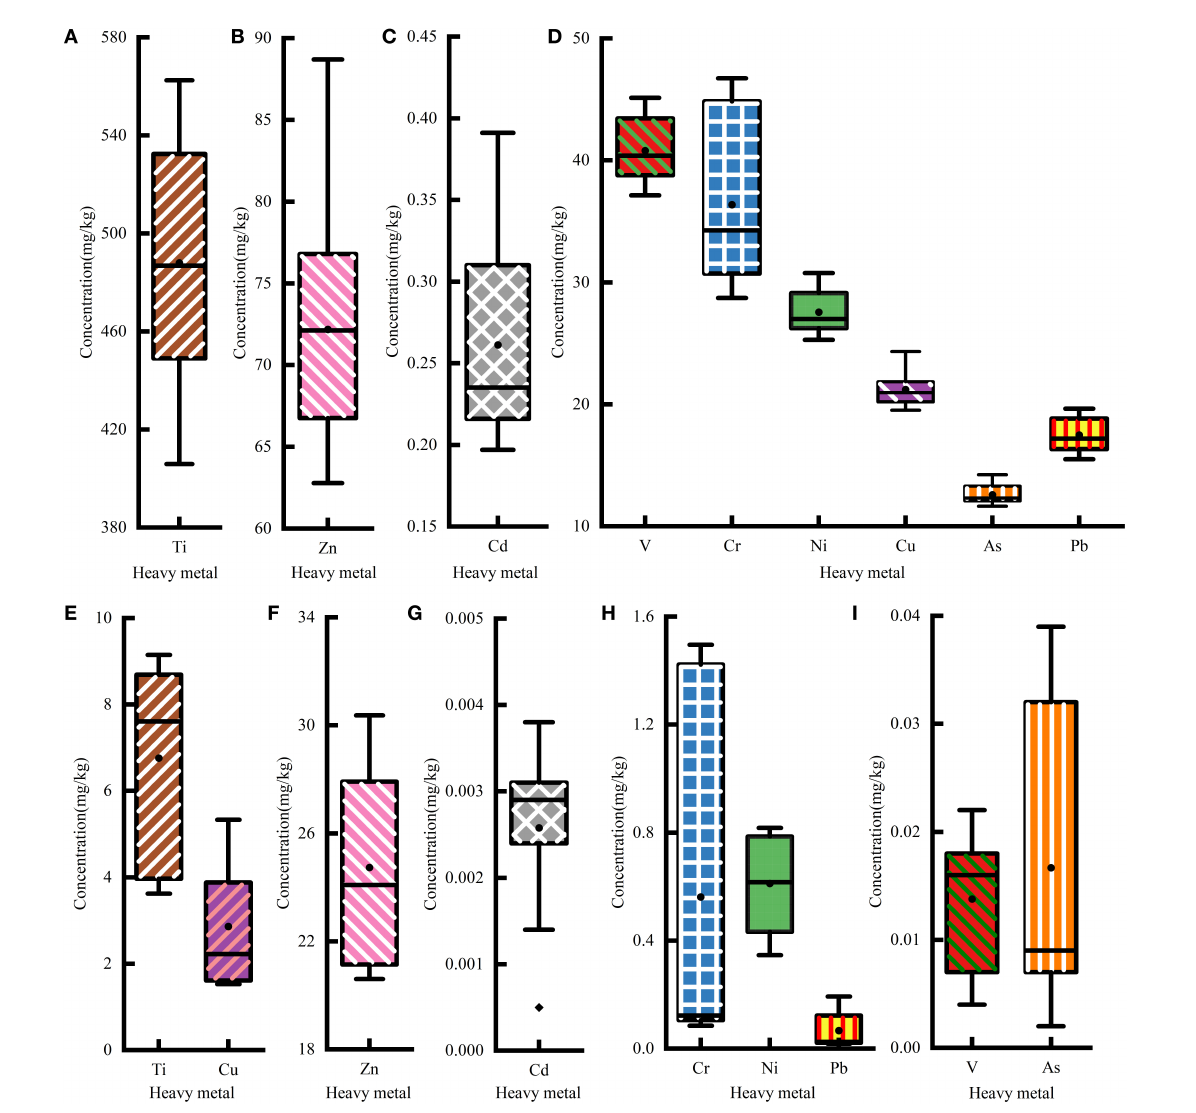
FIGURE2 Statistics of the heavy metal concentration in agricultural soil and maize. The heavy metal concentrations of (A–D) soil and (E–I) maize.